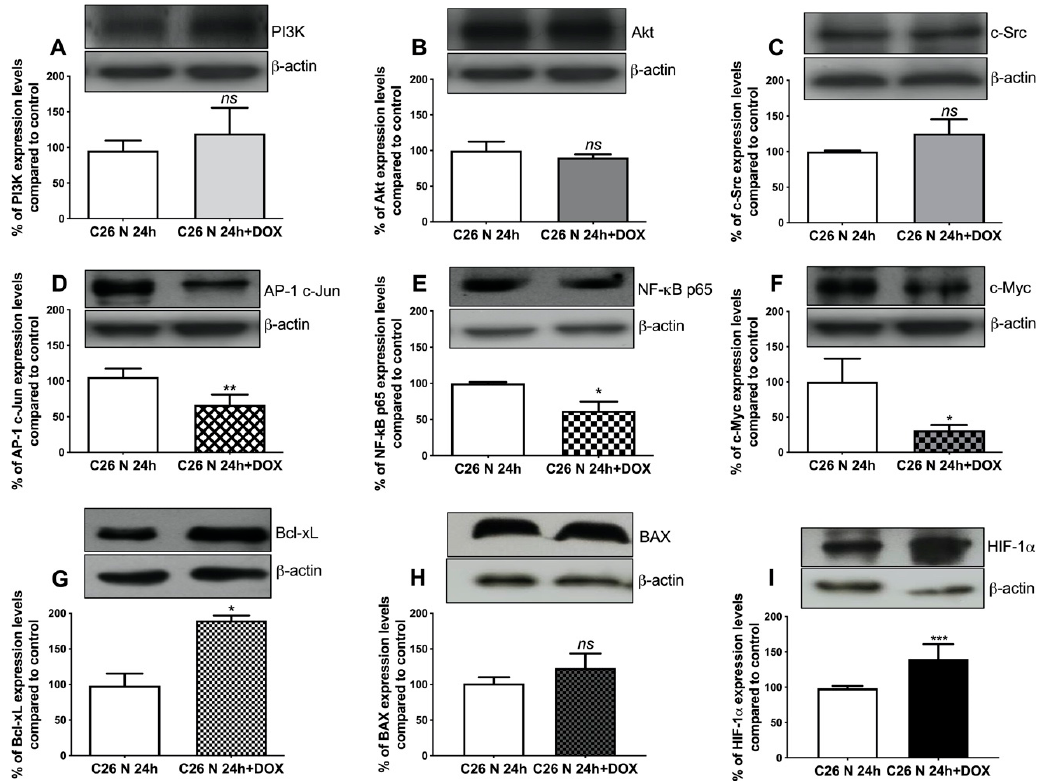
Figure 6. Overview on the molecular changes related to the resistance inducing mechanisms in C26 cells to DOX treatment under normoxia. Cropped Western blot images and their representative graphs displaying the percentage of protein levels after 24 h treatment with 0.3 µM DOX under normoxia compared to controls (the levels of the same proteins in untreated cell lysates) are shown for phosphatidylinositol-3 kinase (PI3K) in panel ( A ); for protein kinase B (Akt) in panel ( B ); for proto-oncogene tyrosine-protein kinase Src (c-Src) in panel ( C ); for the c-Jun subunit of AP-1 transcription factor (AP-1 c-Jun) in panel ( D ); for p65 subunit of nuclear factor kappa-light-chain-enhancer of activated B cells (NF- κ B p65) in panel ( E ); for c-master regulator of cell cycle entry and proliferative metabolism (c-Myc) in panel ( F ); for B-cell lymphoma–extra-large anti-apoptotic protein (Bcl-xL) in panel ( G ), for Bcl-2-associated X protein (BAX) in panel ( H ); and for hypoxia-inducible factor 1-alpha (HIF-1 α ) in panel ( I ). β -actin was used as loading control. Data were expressed mean ± SD of duplicate measurements from two independent experiments. Unpaired t -test was used for statistical analysis of the data; ns : not significant, p > 0.05; *, p < 0.05; **, p < 0.01, ***, p <